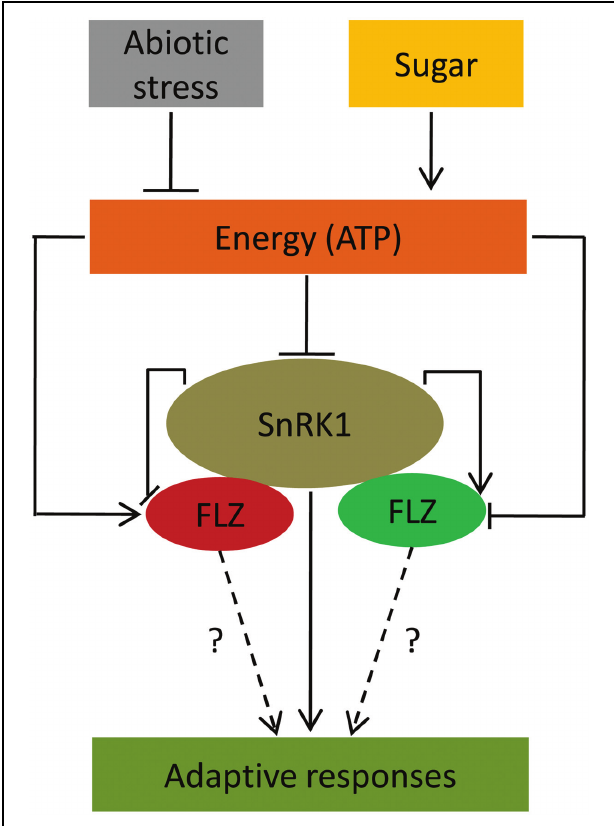
FIGURE 7 | A conceptual model suggesting FLZ genes as a factor involved in the regulation of adaptive response under energy fluctuations and abiotic stress. Sugars, cellular energy level and abiotic stress regulate the expression of FLZ genes. Sugar-induced FLZ genes are shown in red color and sugar down-regulated genes are shown in green color. Stress-driven energy deficit activates SnRK1 which in turn activates the genes involved in the adaptive responses toward stresses (Baena-González et al., 2007; Cho et al., 2012; Confraria et al., 2013). FLZ genes are also involved in the stress mitigation (Hou et al., 2013). SnRK1 transcriptionally regulates FLZ genes. FLZ proteins physically interact with kinase subunits of SnRK1 (Arabidopsis Interactome Mapping Consortium, 2011; Nietzsche et al., 2014); however, the biological significance of these interactions is still